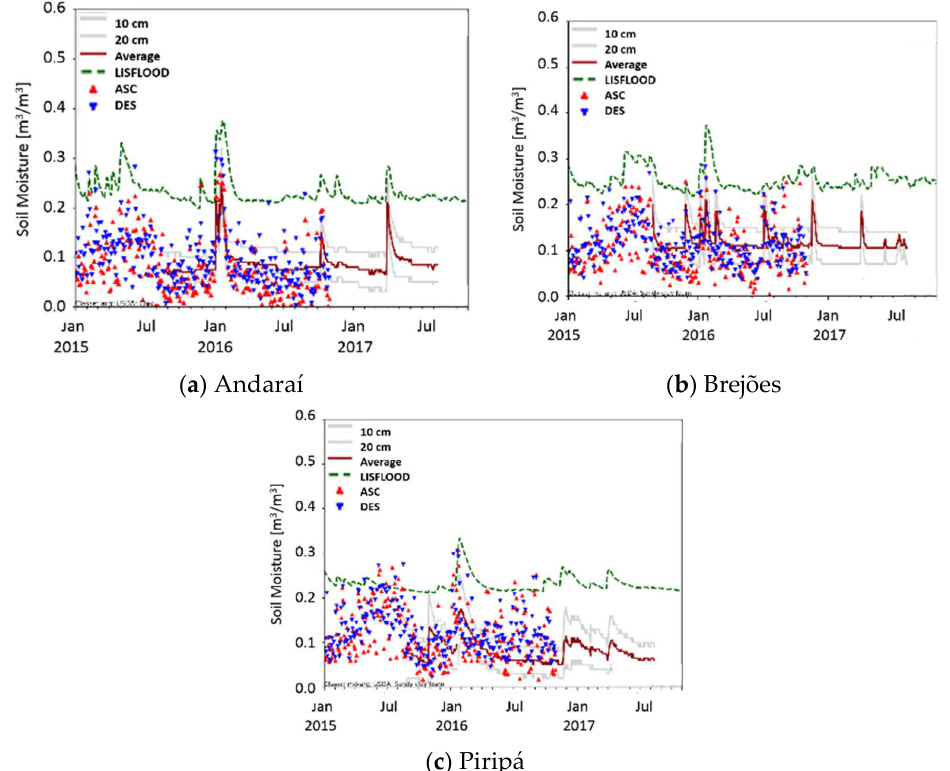
Figure 7. Sample temporal series of SM obtained from CEMADEN stations (10 and 20 cm, gray lines; average value: red solid line), LISFLOOD model (50 cm depth, green line), SMOS L4 products (ascending and descending passes—red and blue line, respectively) during 2015–2016 for different sites located in Bahia (Brazilian Semiarid region). Sites selected to exhibit different correlation values with ascending-pass SMOS SM data. Table 1. Correlation between CEMADEM stations SM at 10 cm and SMOS L4 SM and LISFLOOD model at the ascending or descending satellite passes. In boldface: stations with correlation smaller than 0.5.